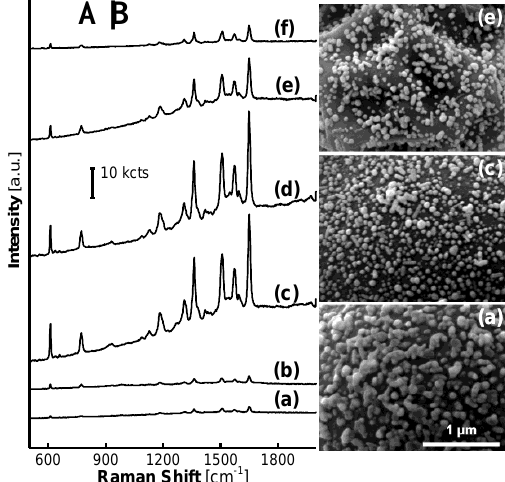
Figure 8. Impact of the MF 6 acid-treatment temperature on R6G-SERRS spectra on AgNP/MF 6 substrate: ( a ) 0, ( b ) 20, ( c ) 40, ( d ) 60, ( e ) 80 and ( f ) 100 ◦ C in ( A ) were collected on the substrate incor- porating the MF 6 microspheres previously treated at varied acid-treatment temperatures, from 0 to 100 ◦ C. The SEM images of the samples in ( a , c , e ) are presented in ( B ). The AgNPs were encapsulated in the oligomer shells as the acid-treatment reaction was executed at low temperatures. ( a , c , e ) in Raman spectroscopy and ( a , c , e ) in SEM are two characterization methods of the same